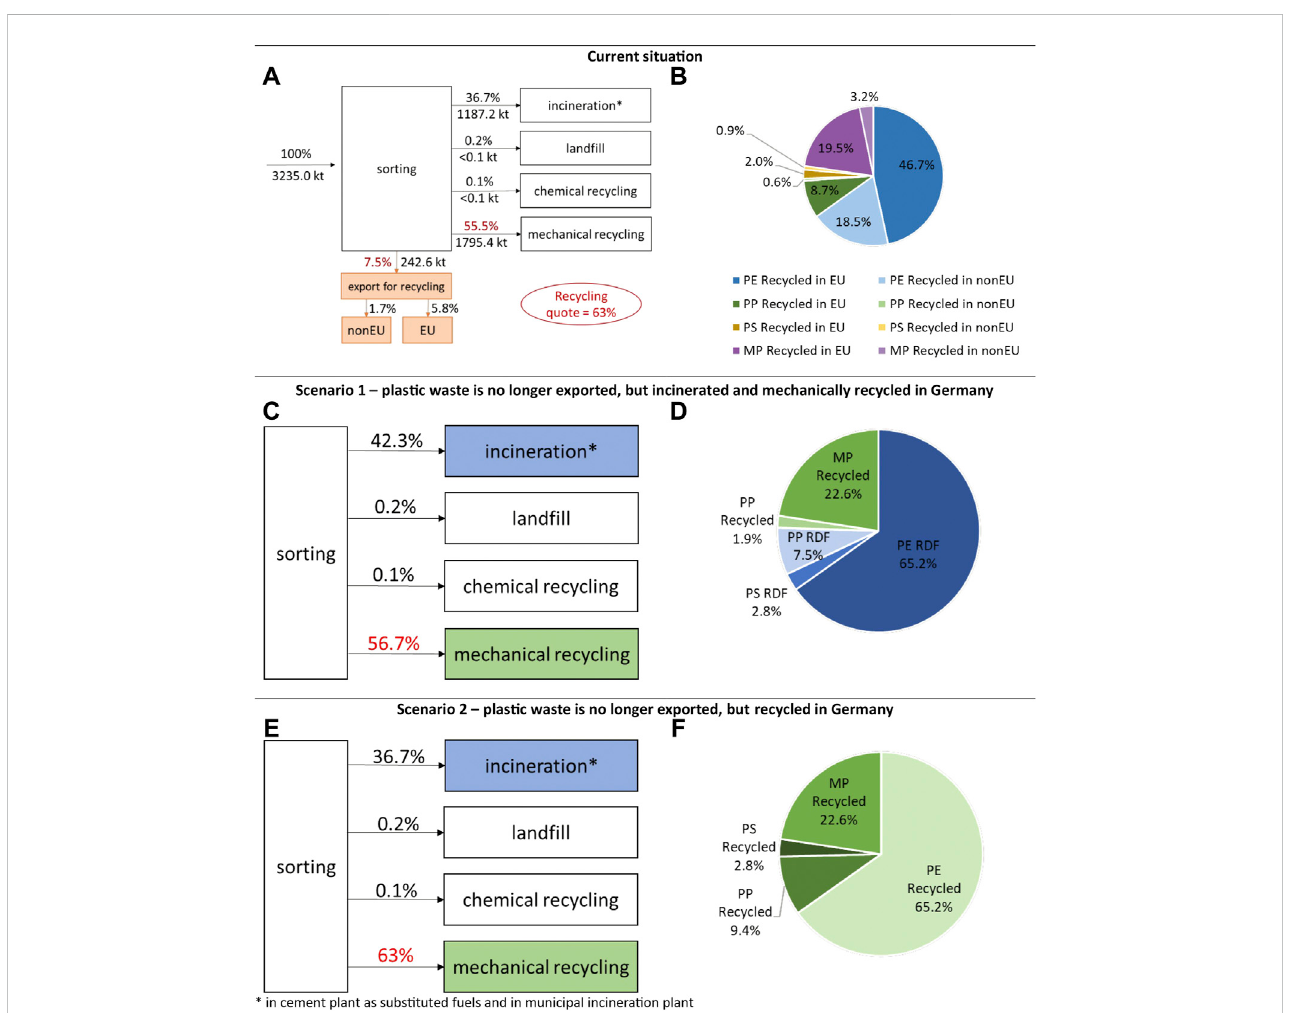
FIGURE 1 Overviewofcurrentsituationandscenarios. (A) and (B) Figuresforthecurrentsituation; (C) and (D) Figuresforscenario1 — areasinblueindicatethetypes of plastics being incinerated in Germany, areas in green indicate types of plastics being recycled in Germany; (E, F) Figures for scenario 2 — areas in green indicatetypesofplasticbeingrecycledinGermany.(PE:polyethylene,PP:polypropylene,PS:polystyrene;MP:Mixedplastic,RDF:refuse-derivedfuel).Values in red indicate the achieved recycling quote in each